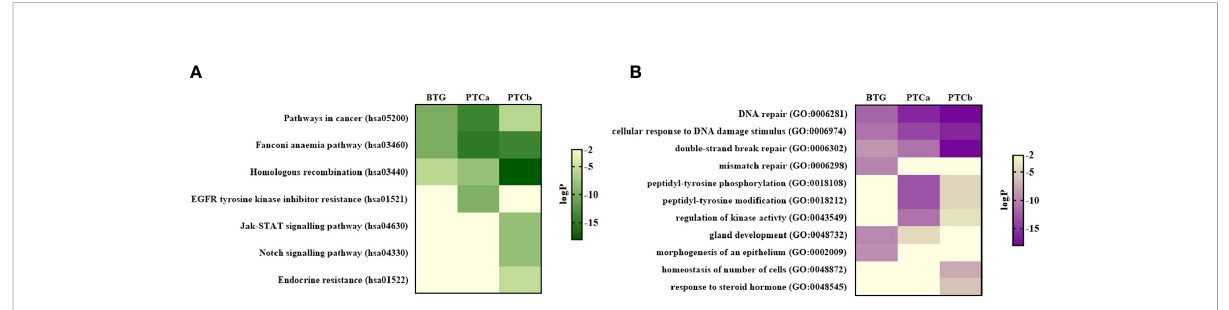
FIGURE 3 Protein-protein interaction (PPI) network analysis showing the top enriched pathways for the three disease groups based on the (A) KEGG database and (B) GO ontology database. Pathways with p-value < 0.01 (LogP < – 2) was considered as signi fi cant. BTG, Benign thyroid goitre; PTCa, Papillary thyroid cancer without BTG background; PTCb, Papillary thyroid cancer with BTG background.